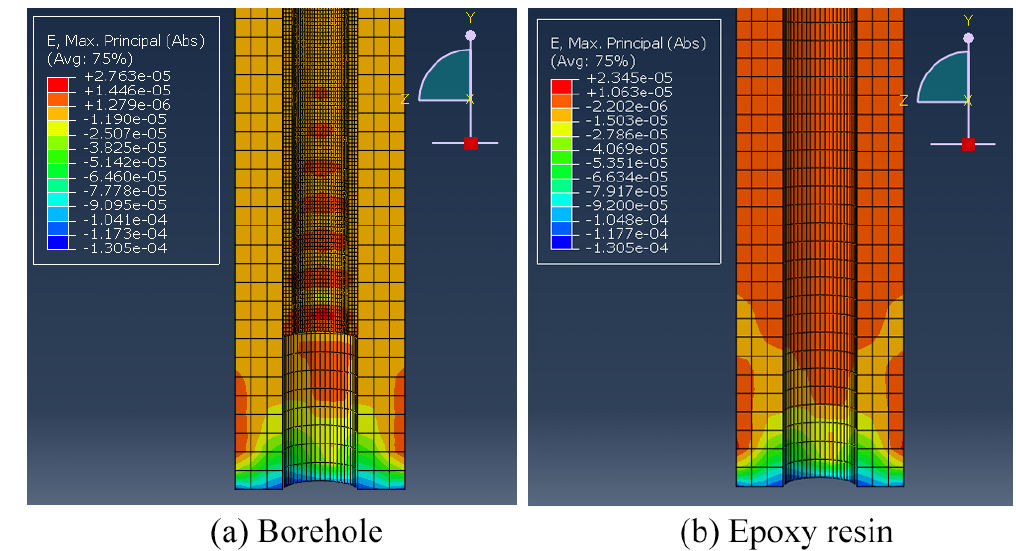
Figure 20. Strain nephogram in the y – z direction of the borehole and the bottom area of the epoxy resin layer.